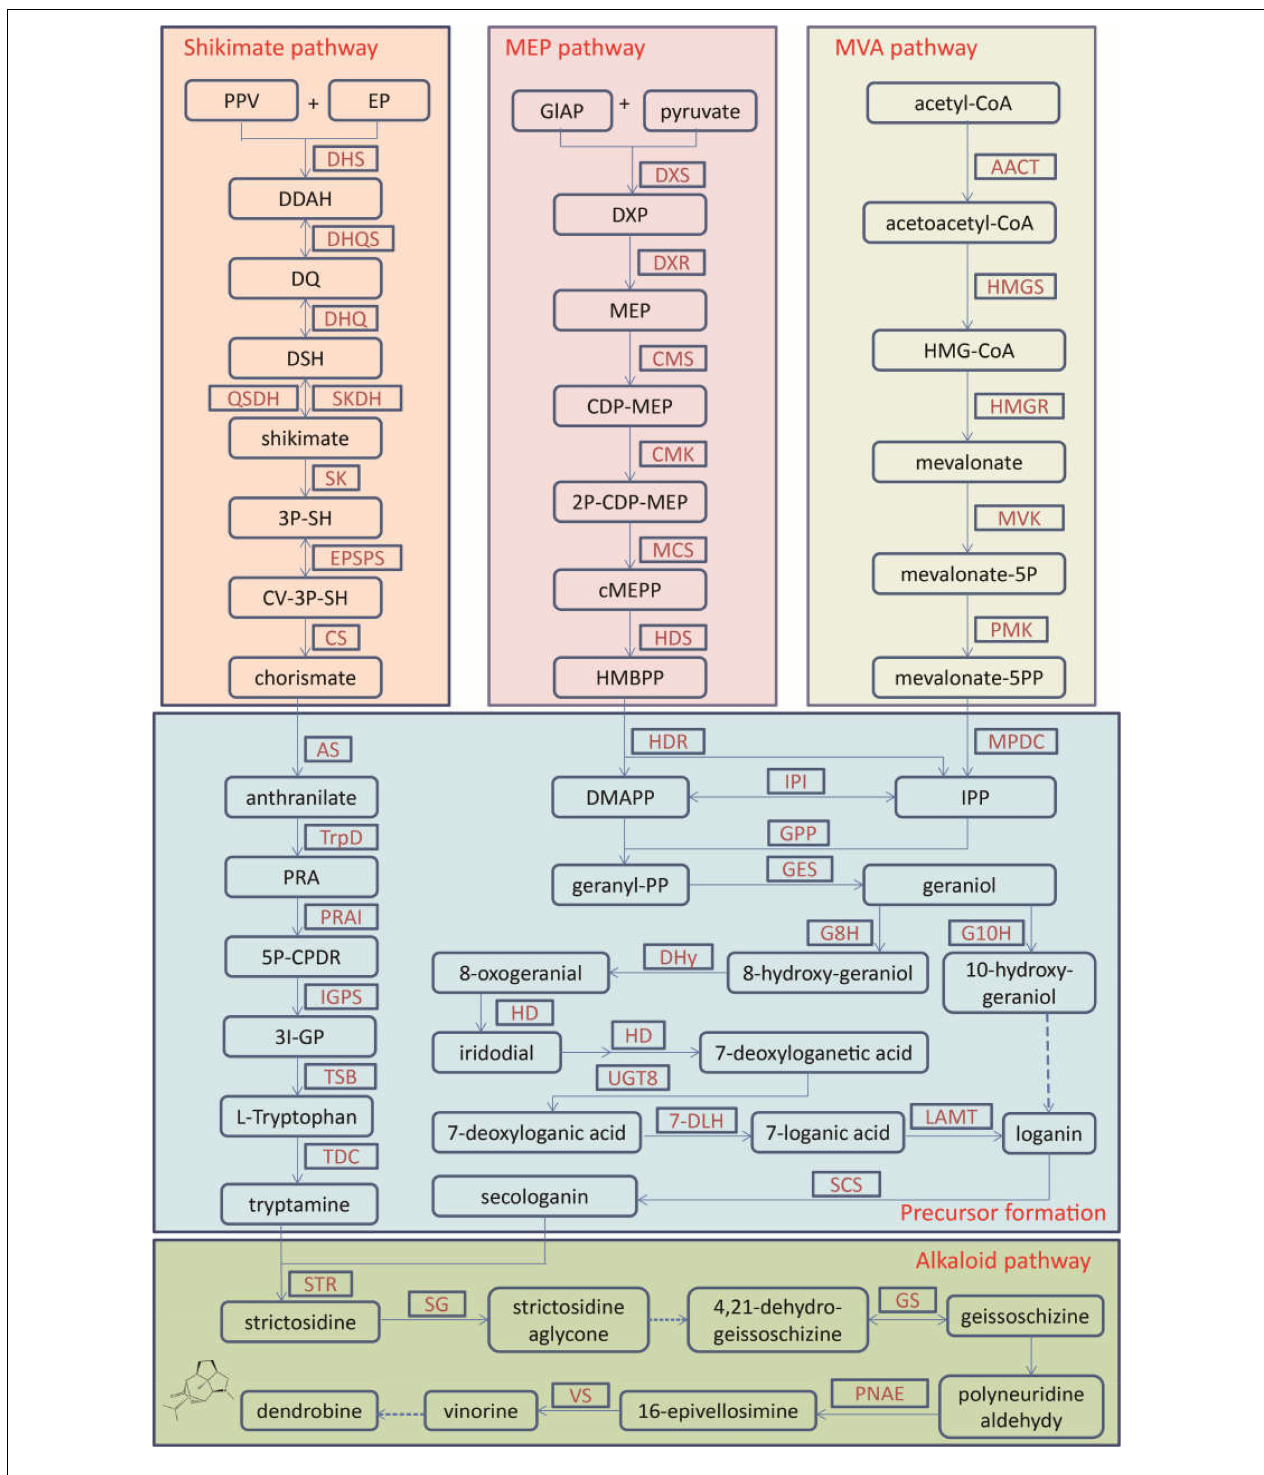
FIGURE 1 | The biosynthetic pathway for terpenoid indole alkaloids in Dendrobium officinale . The alkaloid biosynthesis contains the precursor formation from the shikimate, MEP, and MVA pathways and the alkaloid pathway. 2P-CDP-MEP, 2-phospho-4-(cytidine 5 (cid:48) -diphospho)-2-C-methyl-D-erythritol; 3I-GP, (3-indoyl)-glycerolphosphate; 3P-SH, shikimate 3-phosphate; 5P-CPDRC, 1-(2-carboxyphenylamino)-1 (cid:48) -deoxy-D-ribulose 5-phosphate; CDP-MEP, 4-(cytidine 5 (cid:48) -diphoshpo)-2-C-methyl-D-erythritol; cMEPP, 2-C-methyl-D-erythritol-2,4-cyclodiphosphate; CV-5P-SH, 5-O-(1-carboxyvinyl)-3-phosphoshikimate; DDAH, 7P-2-dehydro-3-deoxy-D-arabino-heptonate; DMAPP, dimethylallyl-PP; DQ, 3-dehydroquinate; DSH, 3-dehydroshikimate; DXP, 1-deoxy-D-xylulose-5-phosphate;